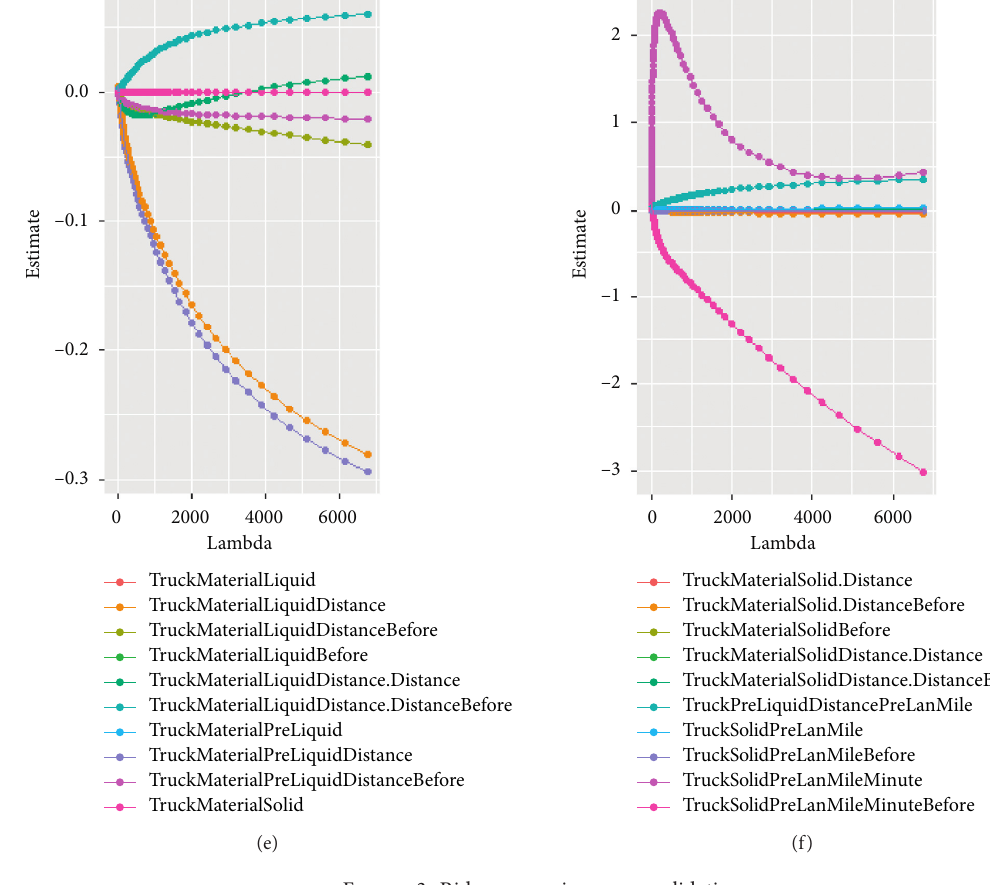
Figure 3: Ridge regression